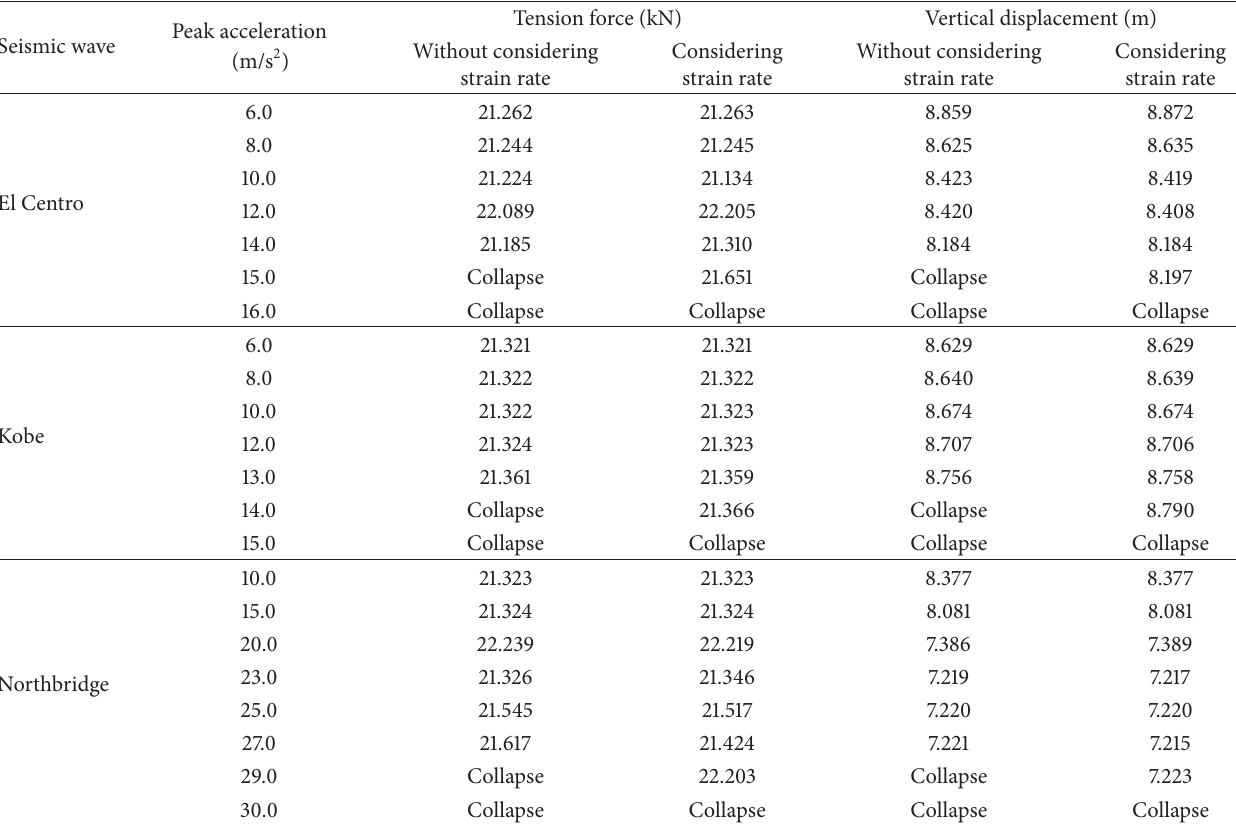
Table 5: Maximum responses of the